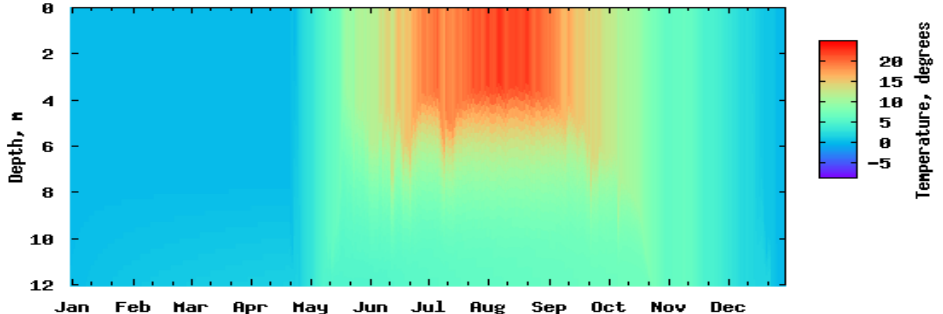
Figure 5. The temperature profile of Merten Talo sea shore (Latitude ( − 90–90): 63 and Longitude